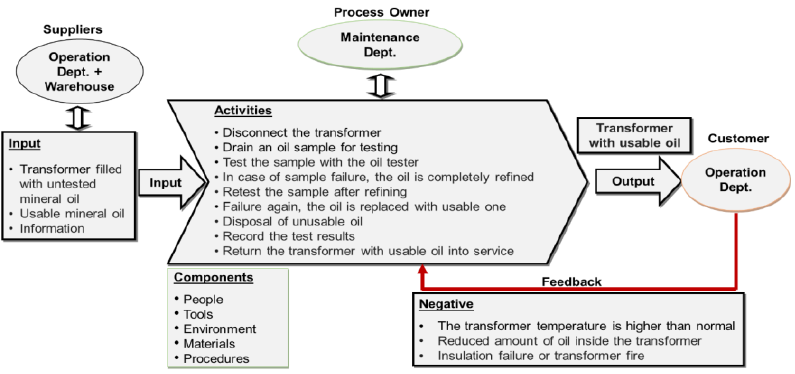
Figure 2. Process of inspecting the insulation system inside DT.